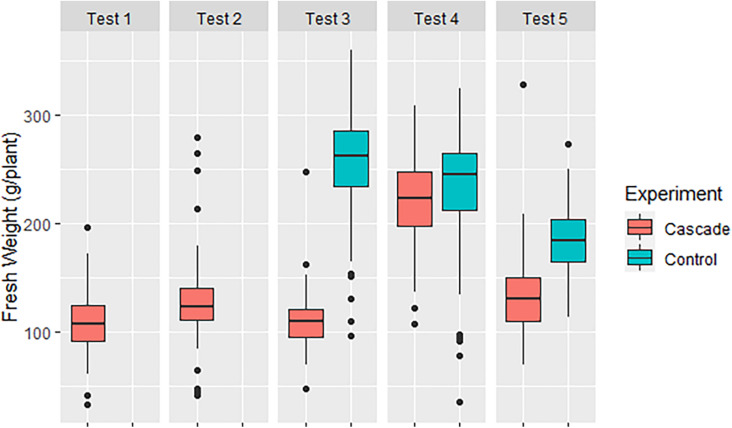
Production of the different tests.